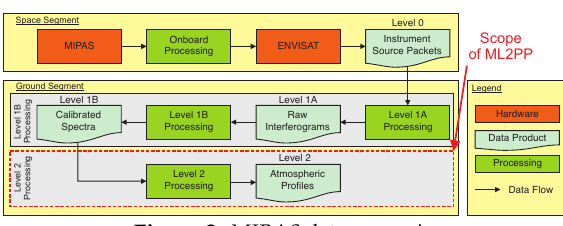
Figure 2: MIPAS data